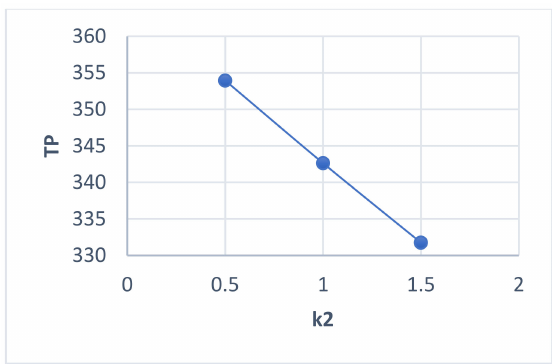
Figure 7. Impact of increasing k 2 on total profit.